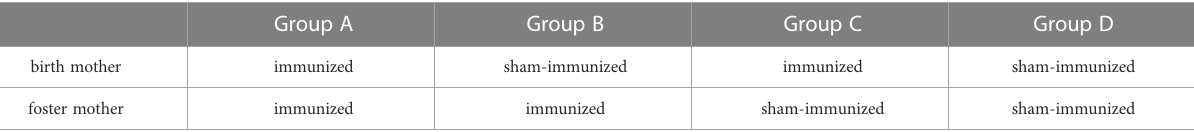
TABLE 1 Four groups of the